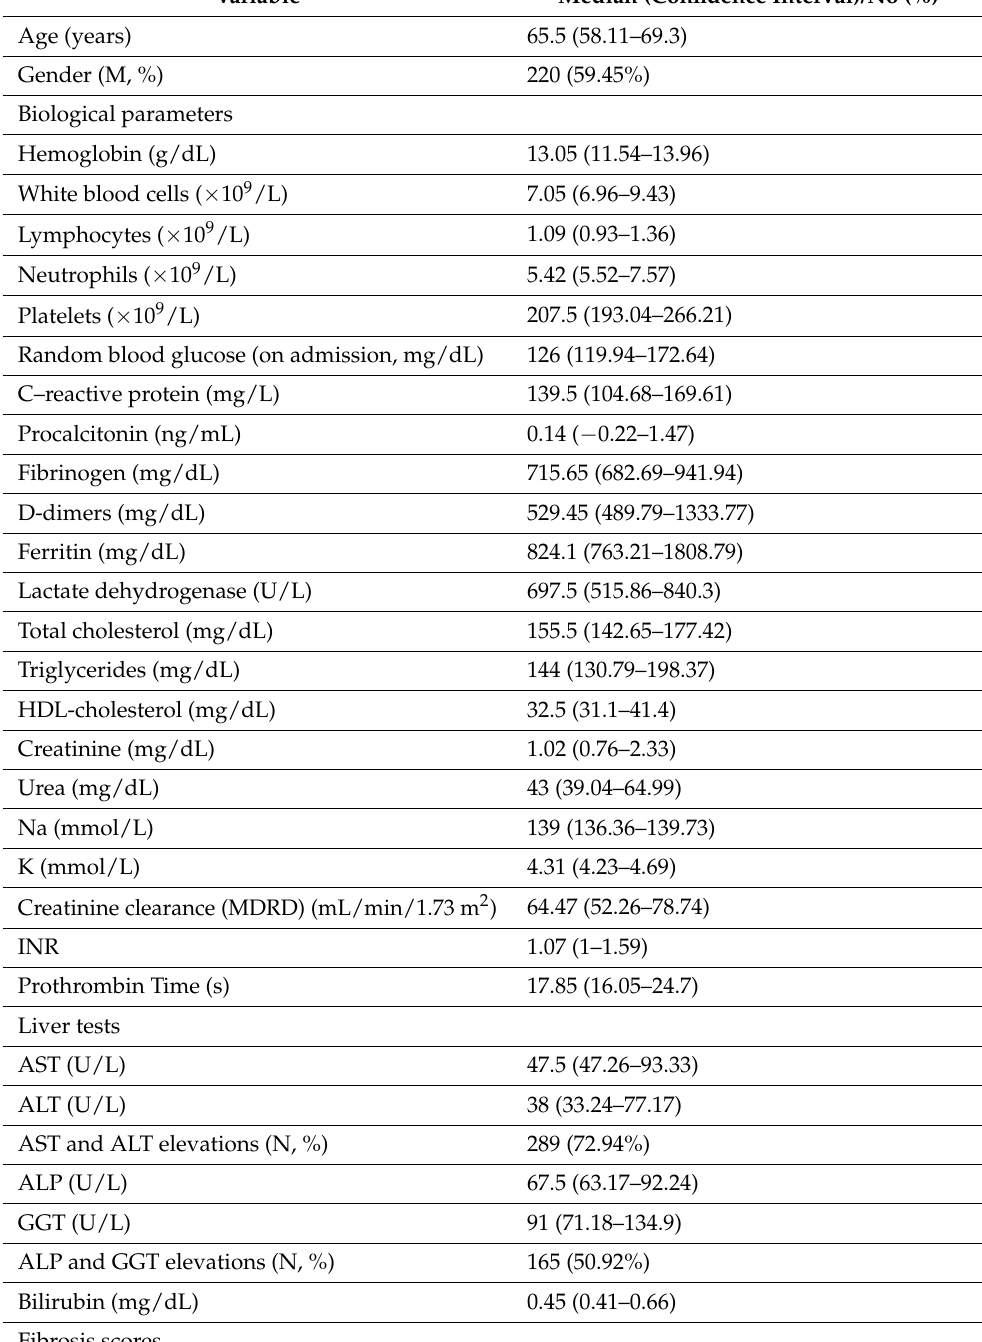
Table 2. Baseline